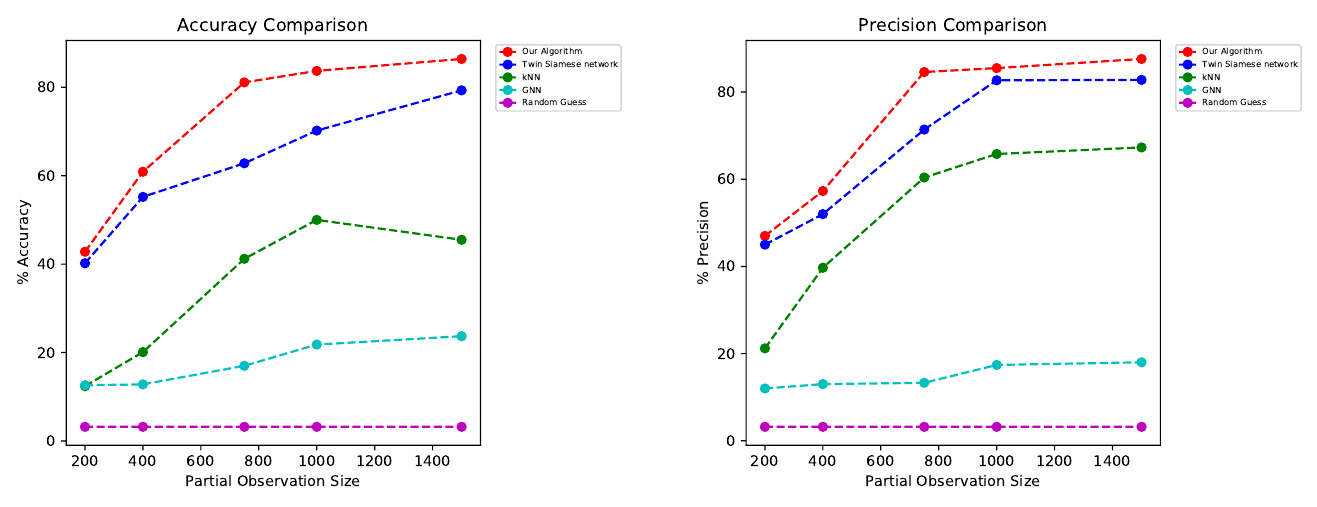
Figure 11. Accuracy and precision comparison with respect to partial observations. In Figure 11, we observed the performance of our algorithm with different samples or partial-observation sizes. We sampled 5%, 10%, 18.75%, 25%, and 37.5% data points as our partial observations, and recovered the signal using this. With a very small number of samples (10% of sample size), our method performed significantly well compared to other methods.